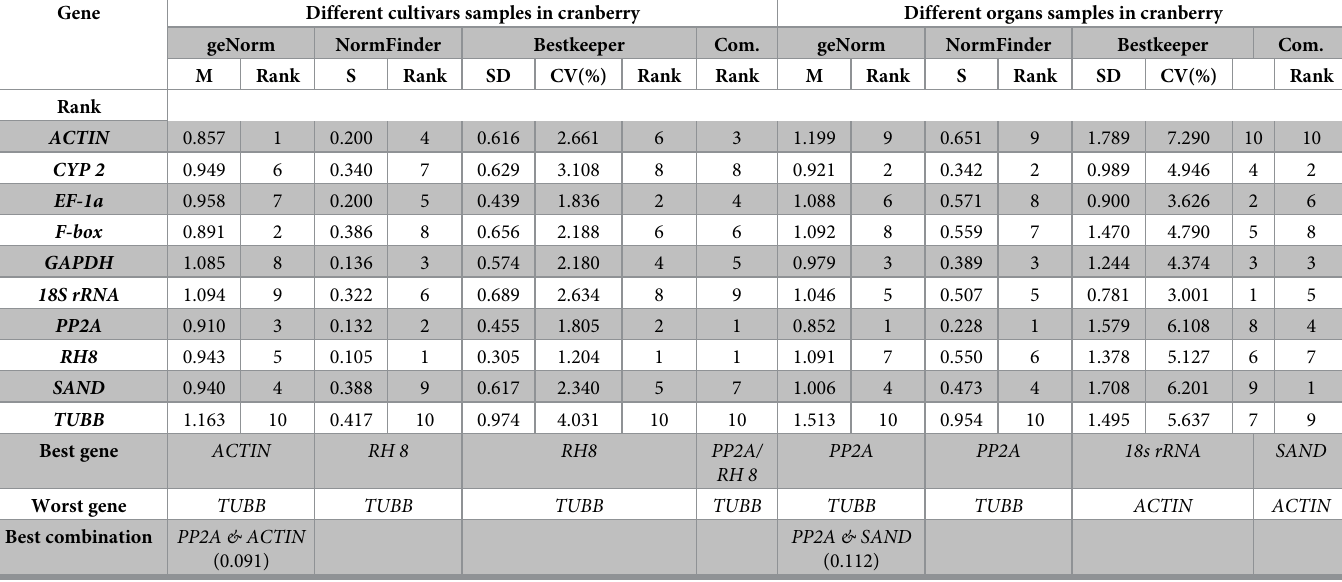
Table 4. Rankings of candidate reference 10 candidate reference genes in different cultivars samples and different organs samples in cranberry using the geNorm, NormFinder and BestKeeper algorithms. Gene Different cultivars samples in cranberry Different organs samples in cranberry geNorm